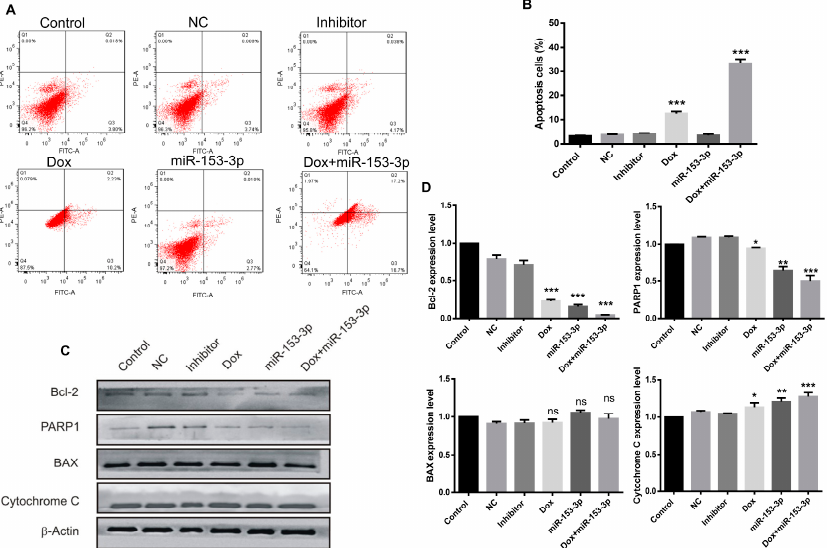
Figure 4. Overexpression of miR-153-3p or Dox treatment induces apoptosis in MCF-7 cells. ( A ) Cell apoptosis was evaluated by flow cytometry after 24 h of treatment. ( B ) Comparison of the percent- ages of apoptotic cells after different treatments. ( C ) Expression levels of Bcl-2, PARP1, BAX, and cytochrome C were detected by Western blot (original blot see Supplementary File S1). ( D ) Quanti- fication of apoptosis-related proteins (ns: not significant; * p < 0.05; ** p < 0.01; *** p < 0.001).